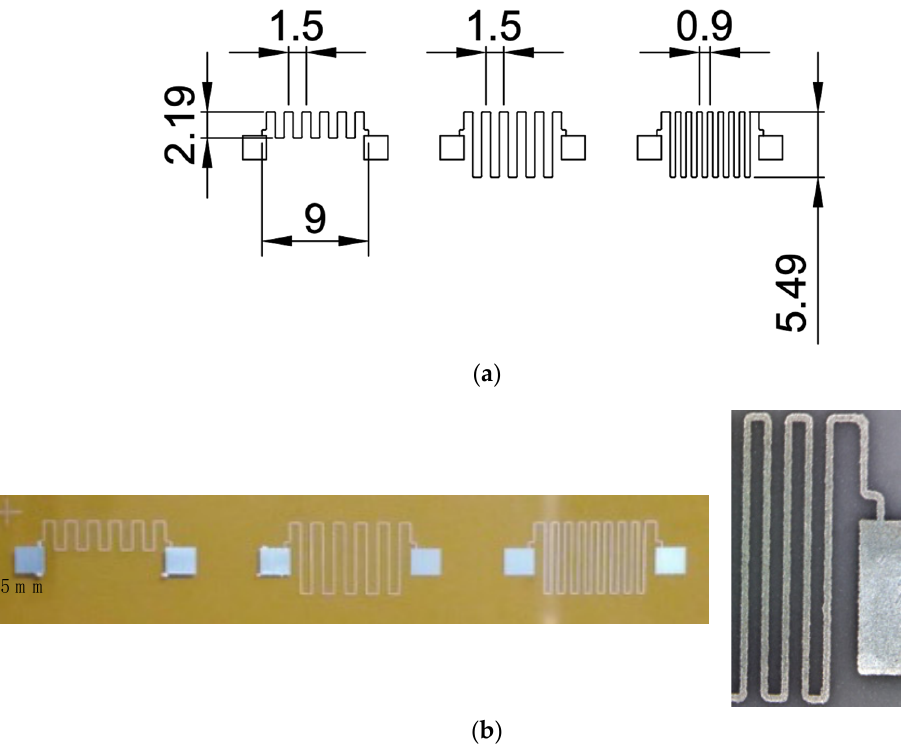
Figure 8. ( a ) 2D model and dimensions (in mm) of printed resistance temperature detector (RTD) and ( b ) printed RTD in three different configurations (33, 66, 99 mm in length) printed on Kapton.